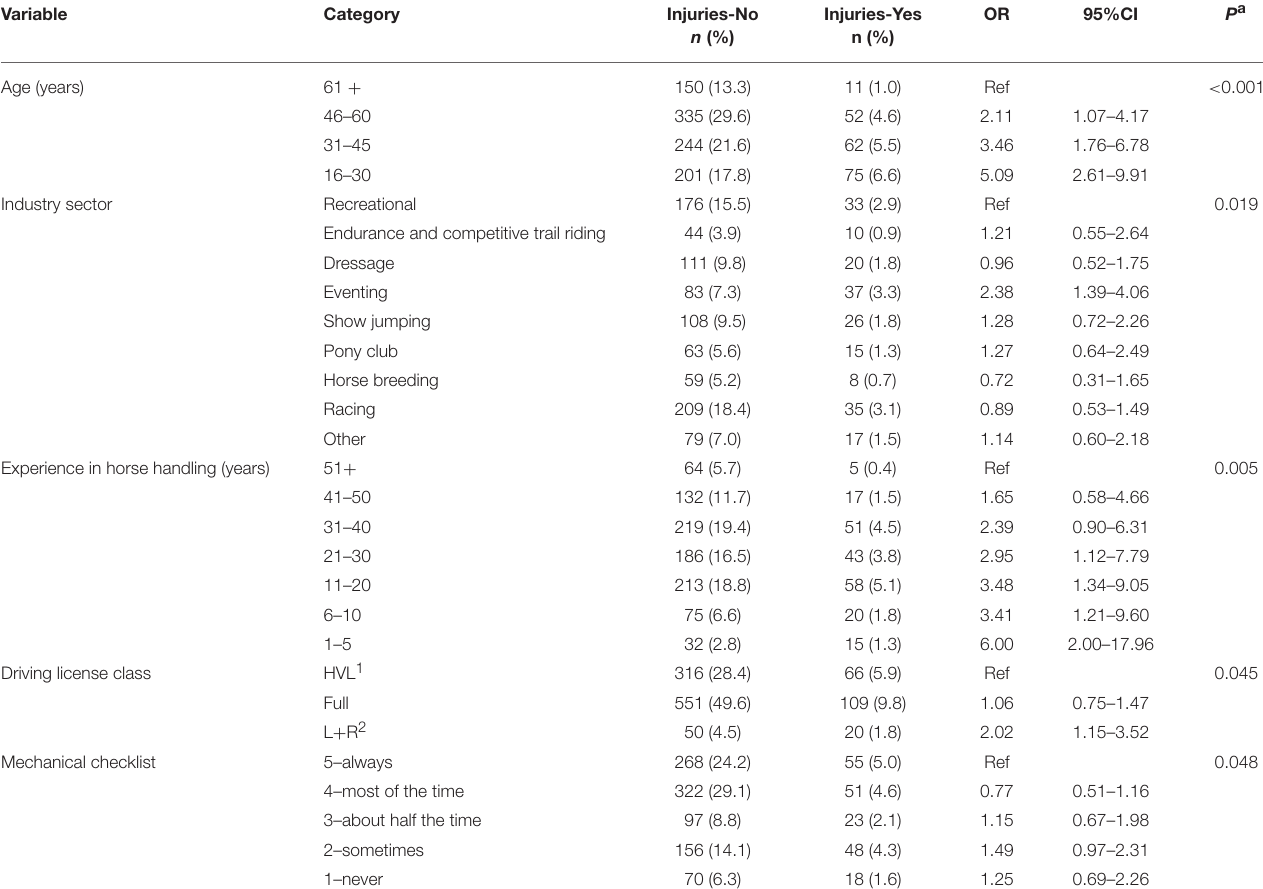
TABLE 4 | Results of univariate logistic regression analyses of associations between injury and the explanatory variables age, industry sector, experience, driving license class and performance of a mechanical checklist.